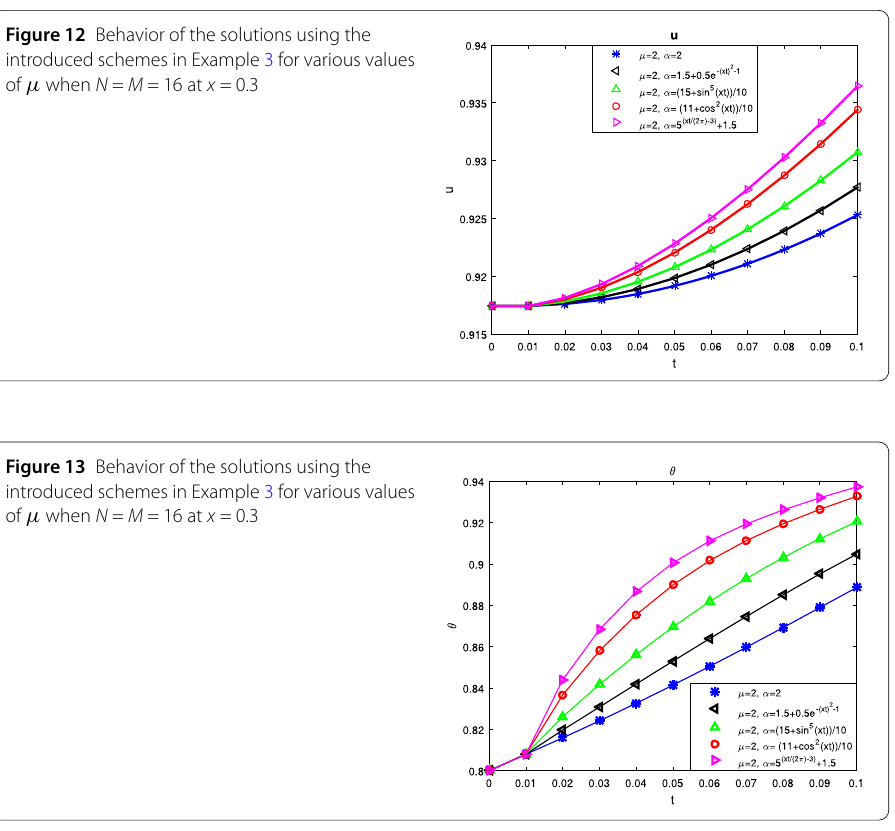
Figure 12 Behavior of the solutions using the introduced schemes in Example 3 for various values of μ when N = M = 16 at x = 0.3